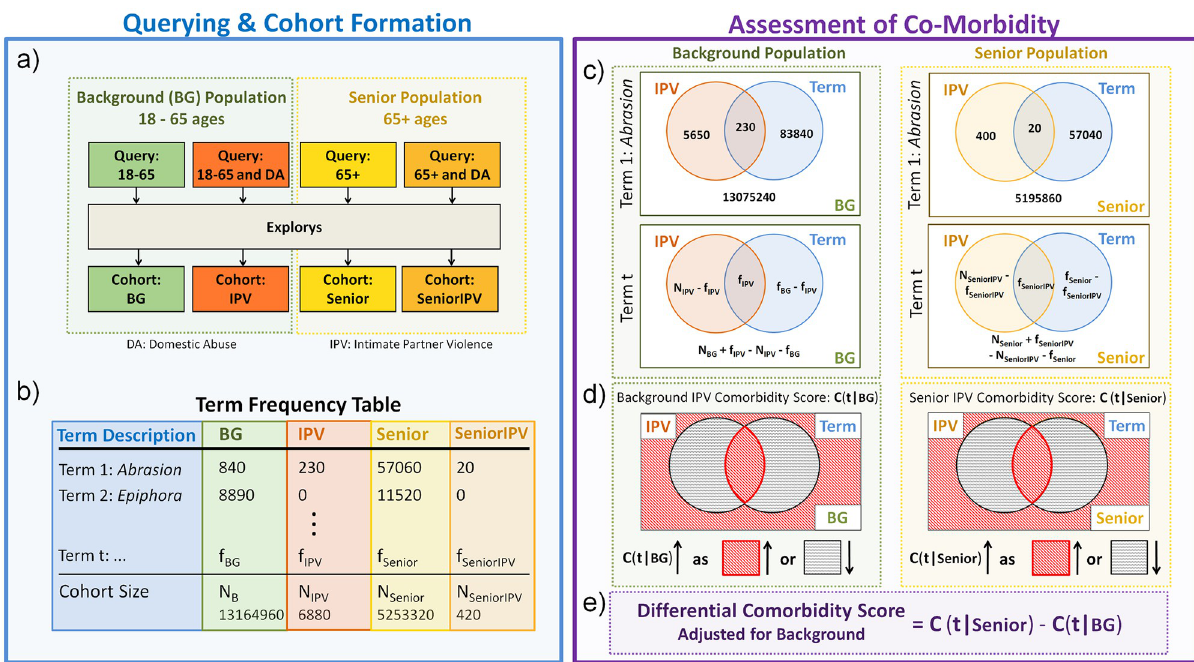
Fig 1. Flowchart illustrating our pipeline for mining electronic health records to identify health correlates of intimate partner violence against older women. (a) Generated cohorts for background and older populations. (b) Each cohort contains a frequency table indicating the number of records for each term. (c) 2 × 2 contingency tables (shown as Venn diagrams) are constructed for both background and older women populations and for each term t . (d) Using the contingency tables, intimate partner violence (IPV) prevalence scores are computed for both populations. (e) A differential prevalence score is computed for each term to uncover terms that are more associated with IPV in older women population compared to background (BG).